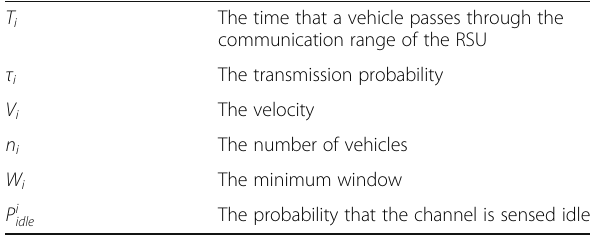
Table 2 Parameters of a vehicle in group i